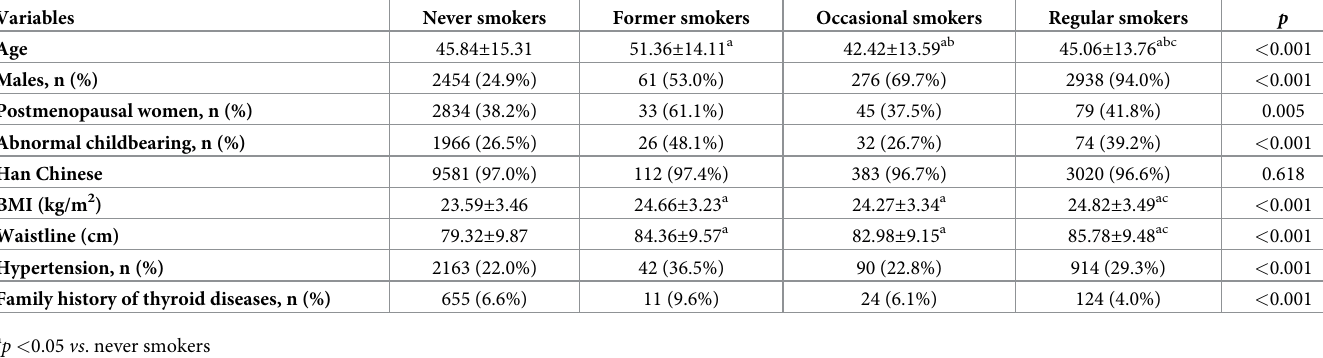
Table 1. Demographic characteristics of study participants in each